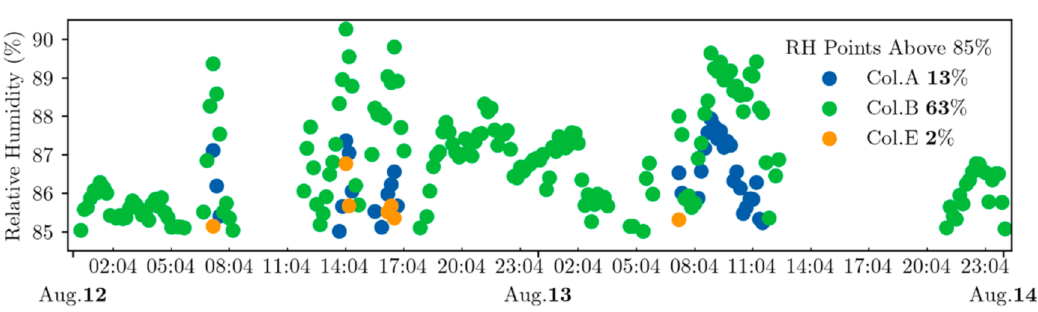
Figure 13. Substantial records of rather high relative humidity (over 85%) of the two consecutive days’ entire observations recorded by nodes from Column A and Column